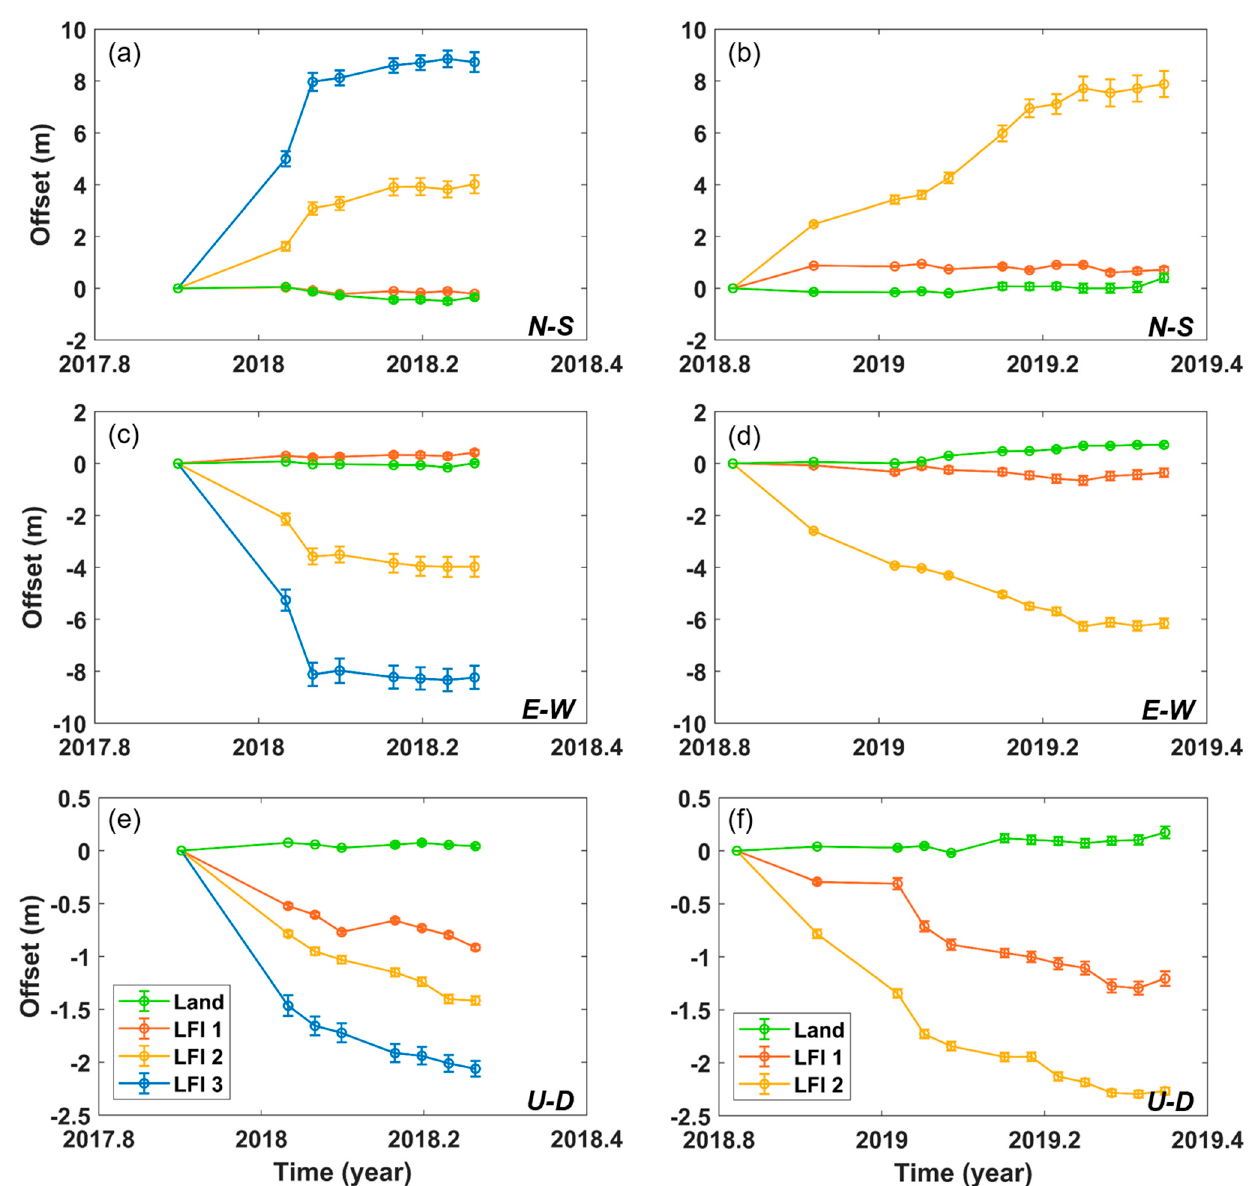
Figure 7. 3D time-series analysis of 2017–2018 (( a ) north–south, ( c ) east–west, ( e ) up–down) and 2018–2019 (( b ) north–south, ( d ) east–west, ( f ) up–down) cycles. The green, orange, yellow, blue lines represent the offsets observed from the land and landfast ice (LFI 1-3) spots marked in Figure 5d, respectively. The vertical error bars represent the standard deviation in 5 by 5 pixels window.